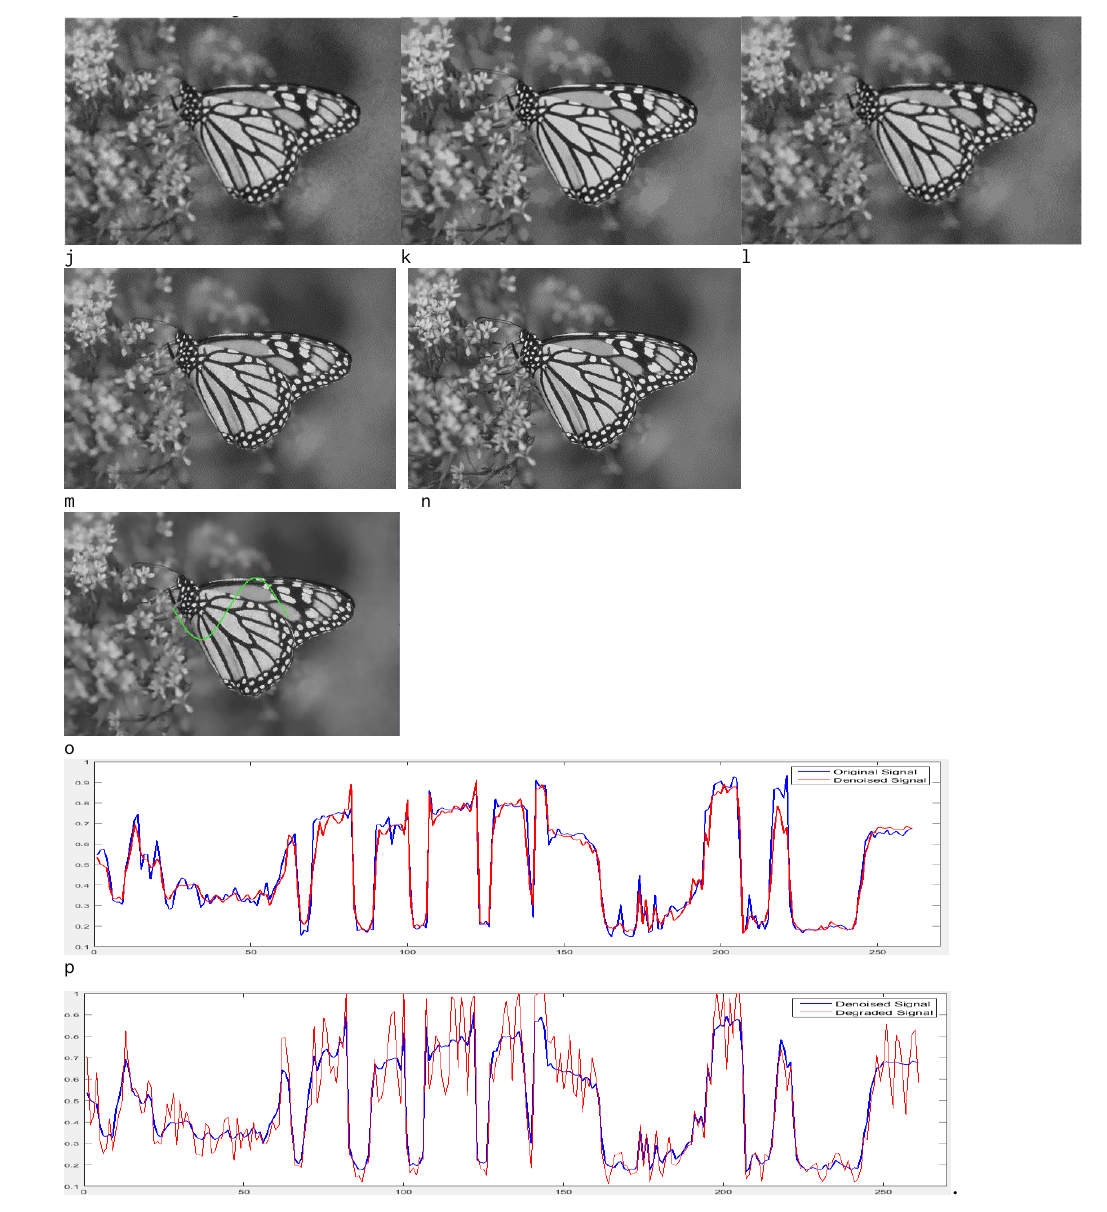
Figure 10. Performance comparison of different techniques using the Monarch image. ( a ) Noisy; ( b ) guided; ( c ) Frost; ( d ) Lee; ( e ) bitonic; ( f ) WLS; ( g ) NLLR; ( h ) ADMSS; ( i ) SRAD; ( j ) SRAD-guided; ( k ) SARBM3D; and ( l ) proposed method of Hyunho Choi et al. ( m ) Proposed method, ( n ) original image, ( o ) signal on image, ( p ) comparison of the original signal and denoised signal, ( q ) comparison of the denoised signal and degraded signal.